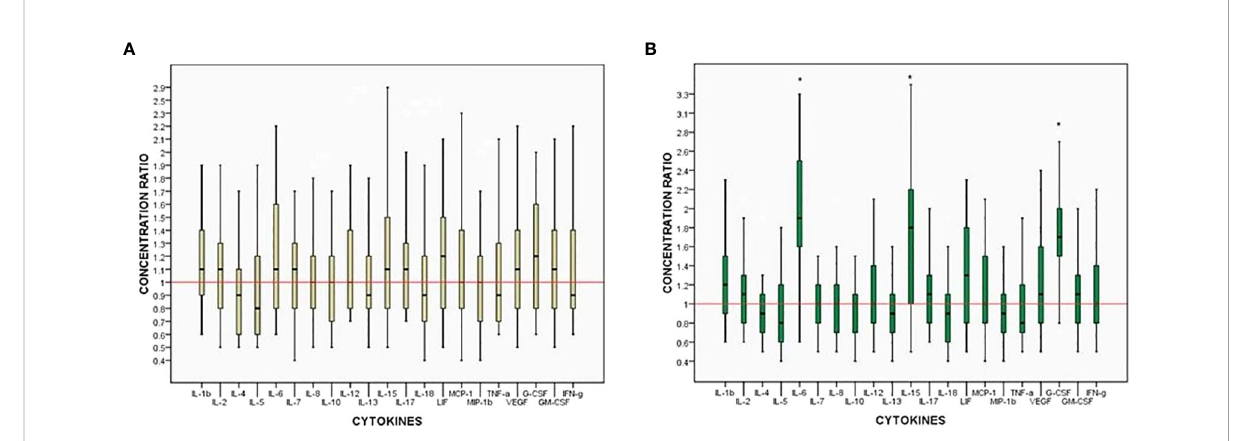
FIGURE 2 Ratios of intra-patient endometrium cytokine concentrations between two cycles. Box: median, 25% – 75% interquartile range (IQR). Whiskers 10% – 90% IQR. (A) Non-pregnant women. (B) Pregnant women.